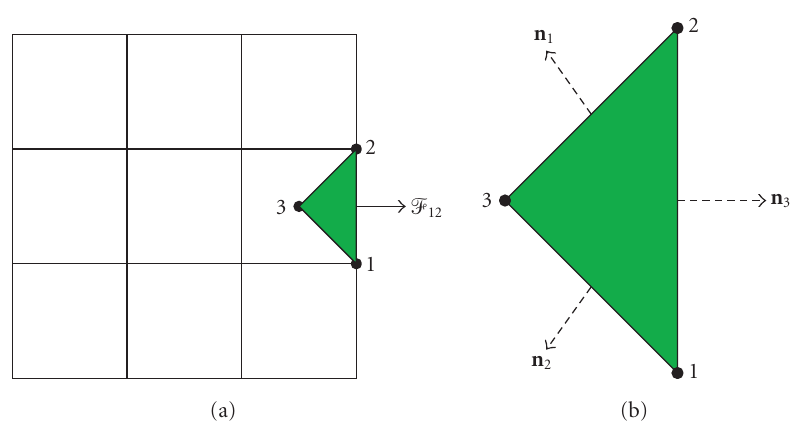
Figure 2.3 . Implementation of the Dirichlet boundary condition. (a) A 3 × 3 mesh. Pressure is spec- ified at the boundary points 1 and 2. Flux ( (cid:2) 12 ) through the edge 12 is expressed as a linear combi- nation of the potentials at the locations 1, 2, and 3; see (2.10). (b) Boundary triangle. Here, n i with i = 1, ... ,3 are the normal vectors on the